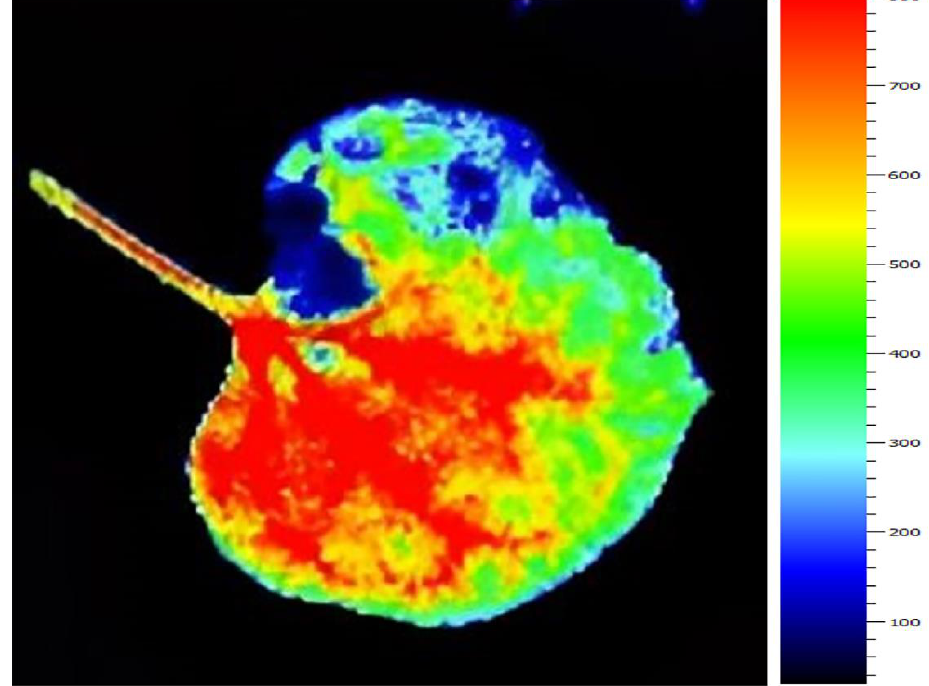
Figure 8. Fluorescence image of an infected tobacco leaf. False-blue color spots indicate where a chlorophyll deficiency is present.